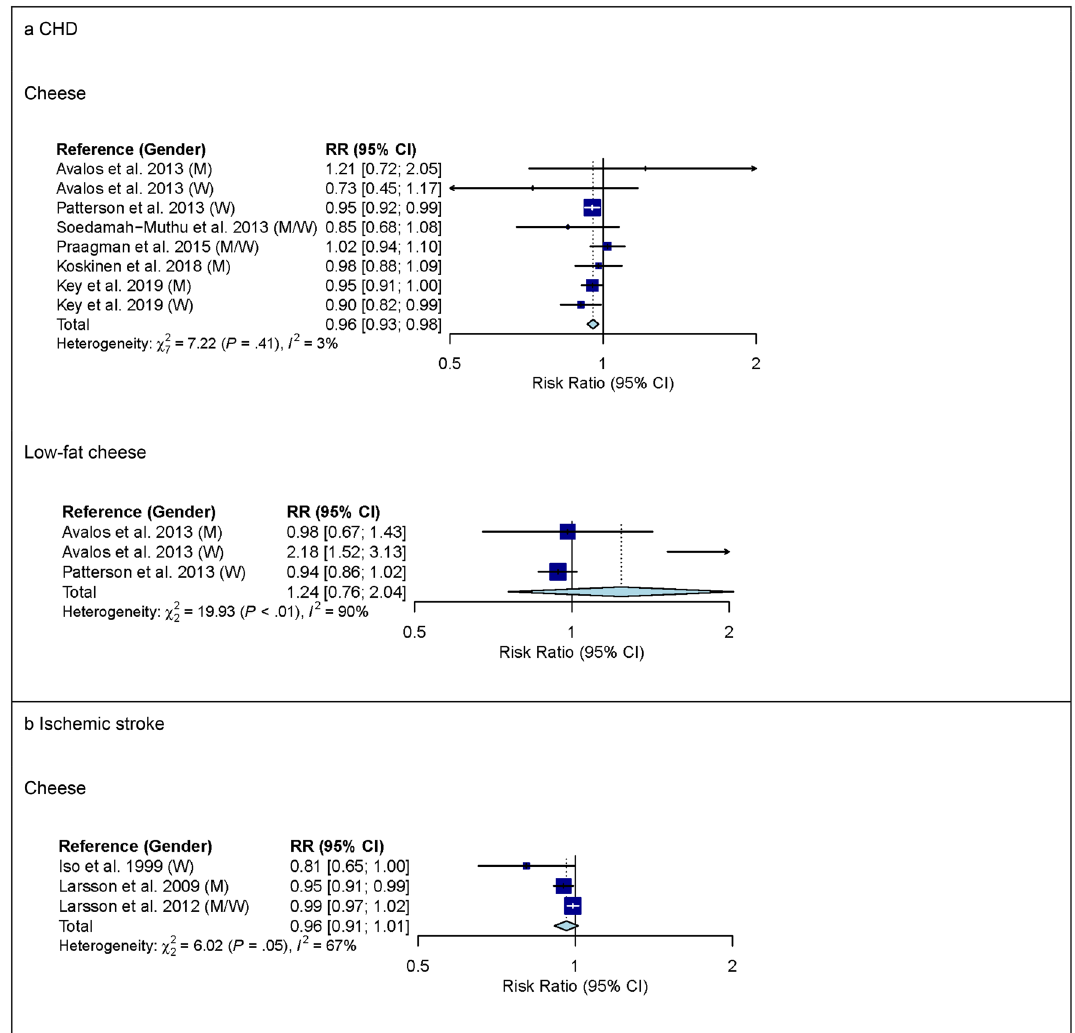
Figure 3. Linear dose–response meta-analysis. Summary RR of CHD (panel a ) and ischemic stroke (panel b ) per 20 g higher intake of cheese/day. P < 0.05 for heterogeneity for the association between cheese and ischemic stroke. CHD coronary heart disease; CI confidence interval; M males; RR risk ratio; W